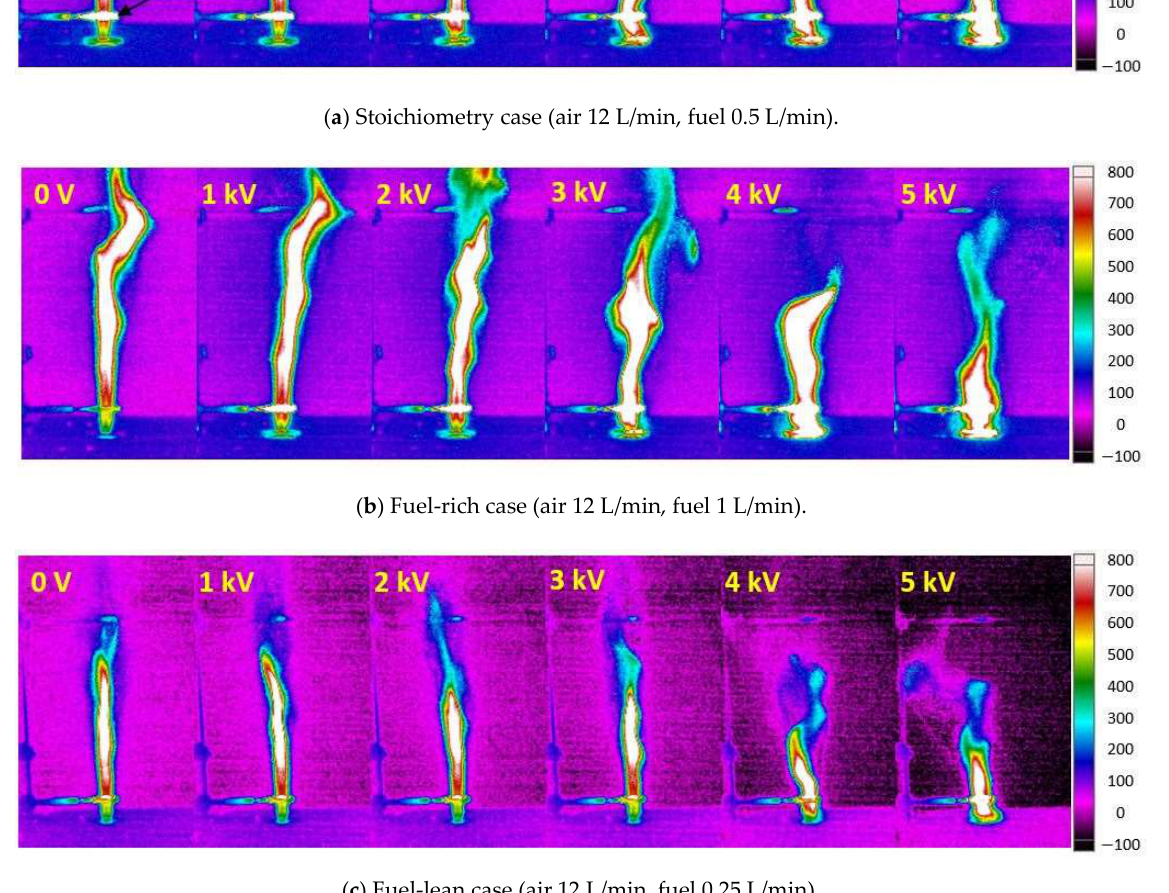
applied to the electrode increased. In all cases under the same voltage, as the amount of